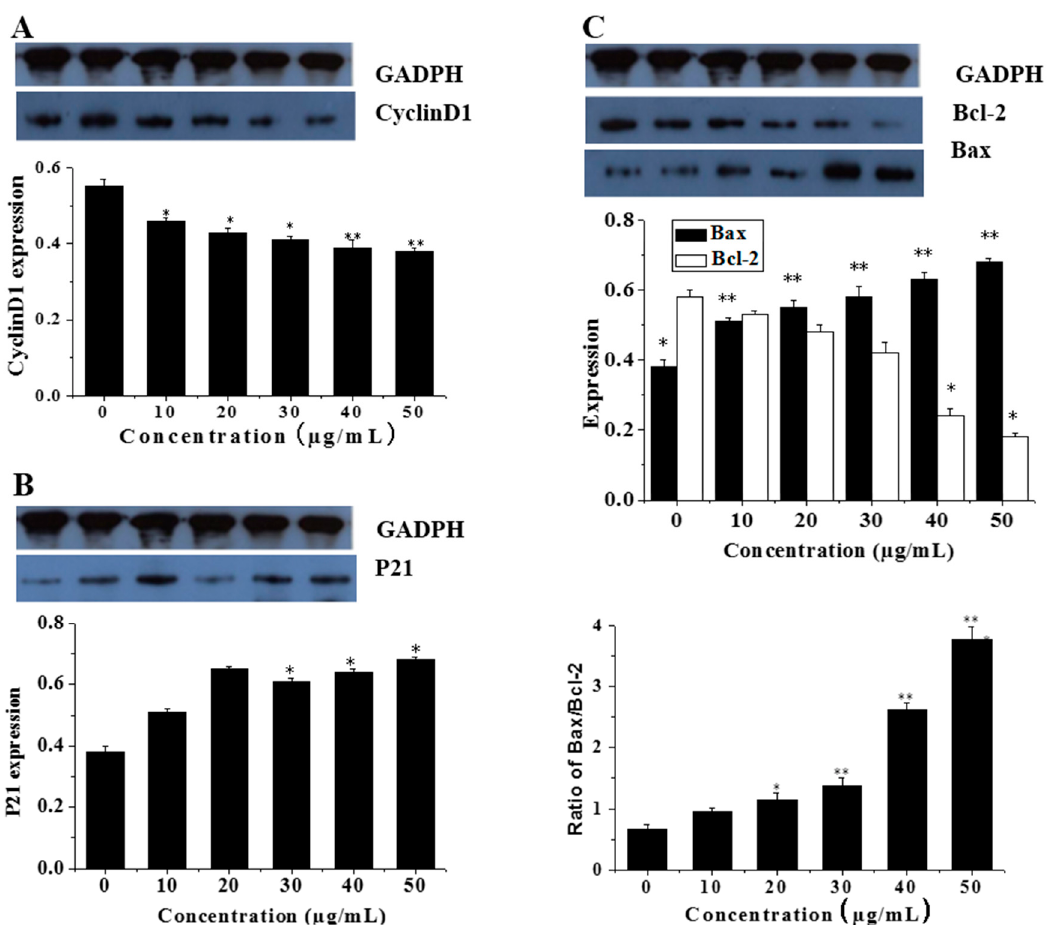
Figure 6. Western blotting analysis of apoptosis regulatory proteins in Caco-2 cells after treatment with increasing concentration of CGC. Densitometry was performed for the different proteins and normalized to the respective housekeeping control ( A – C ). n = 3, mean ± SD. * p < 0.05 and ** p < 0.01, compared to control group.